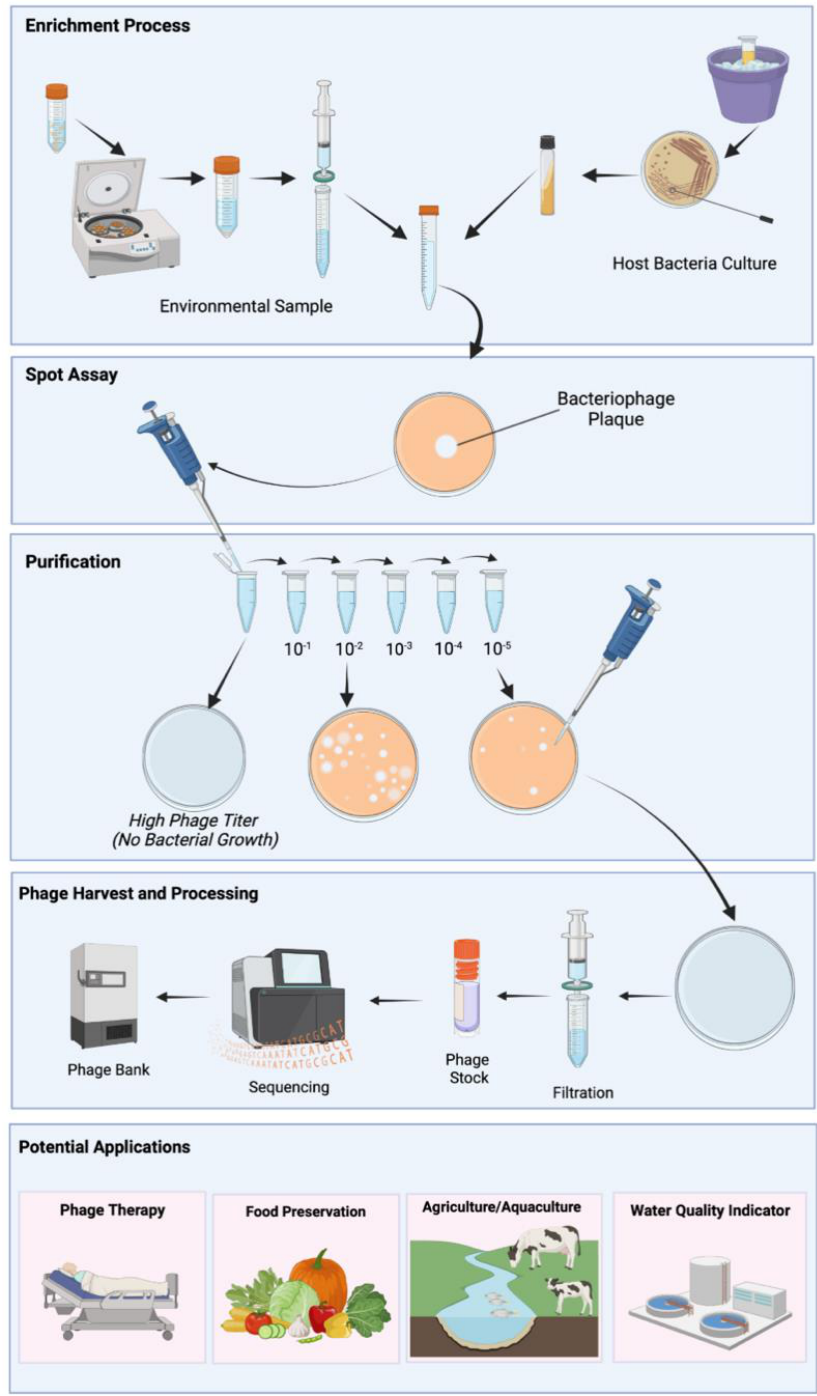
Figure 2. Process of bacteriophage isolation for therapeutic use. Phage isolation begins with environmental water samples that are filtered to remove bacteria. The resultant filtrate is combined with a bacterial culture of interest in a process known as enrichment, whereby the concentration of phages effective against the specific host bacteria increases. After enrichment, spot assay allows for visualization of phage presence on a solid bacterial lawn. Phages from the resultant phage plaque are combined with a neutral buffer, and serial dilutions are performed before further plating to obtain distinct phage plaques of homogenous morphology. After phage harvest, amplification, sequencing, and characterization are performed to determine phage novelty. Phages are added to bacteriophage banks and international phage directories to be later employed in different applications.